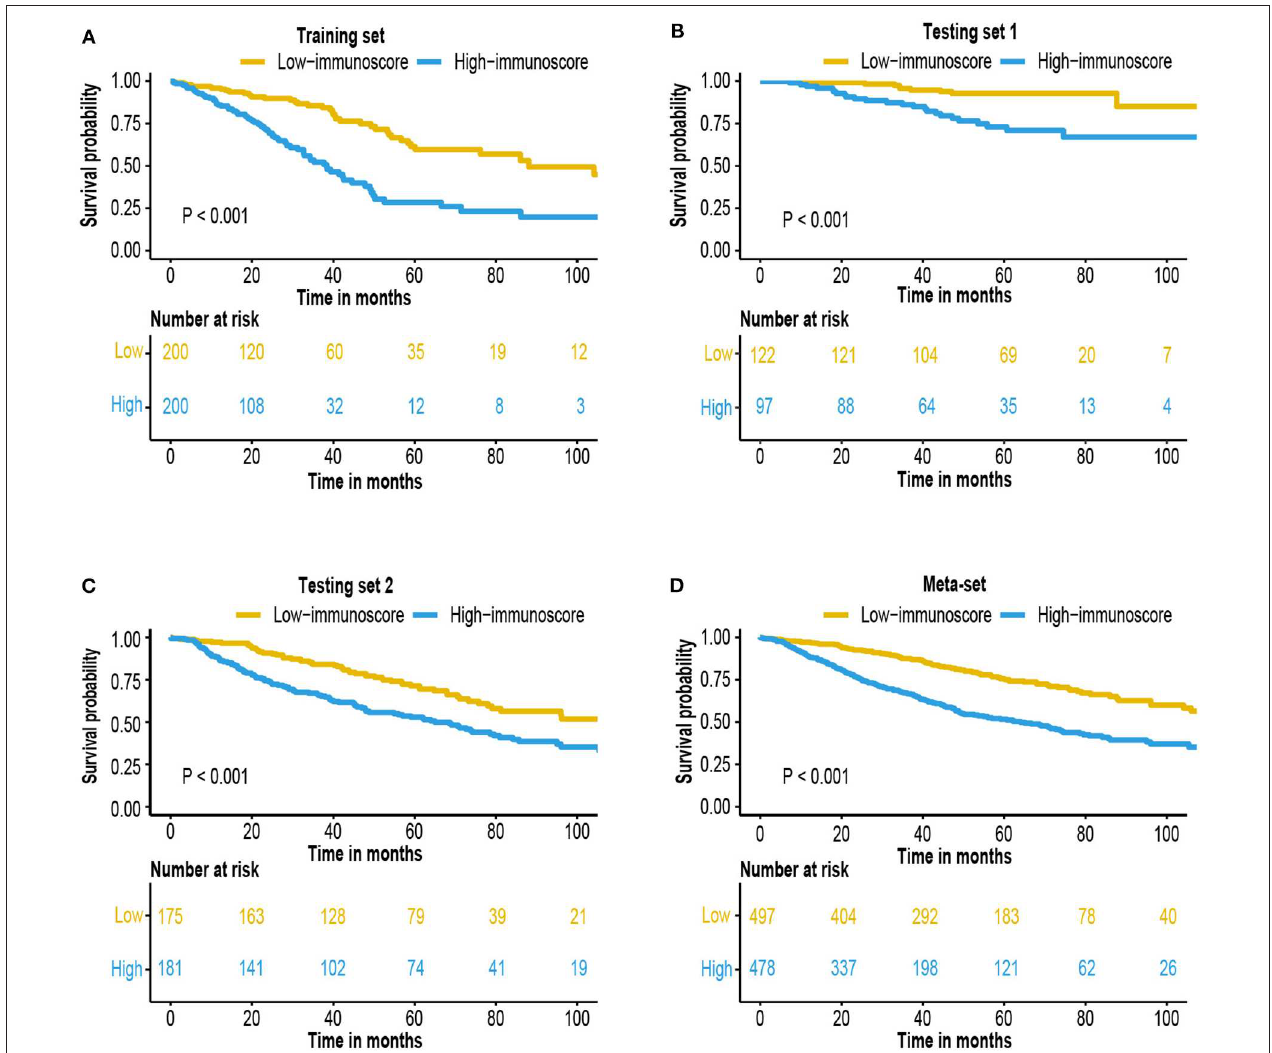
FIGURE 3 | Survival analysis of the immunoscore. Kaplan–Meier curves for patient overall survival by immunoscore group in the (A) training set, (B) testing set 1, (C) testing set 2, and (D) meta-set.